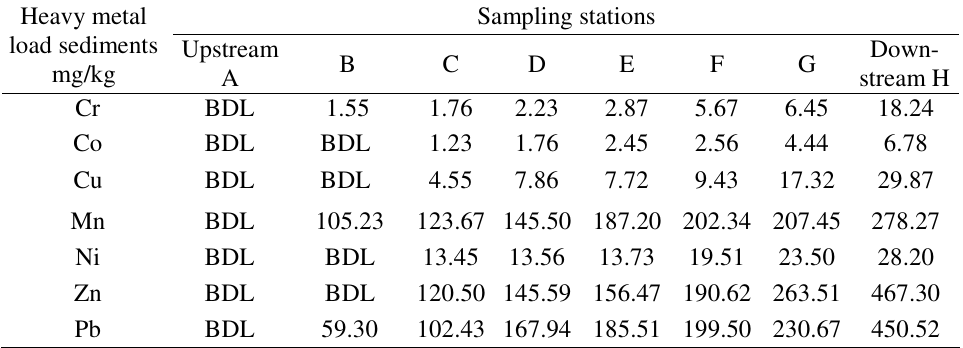
Table 6. Heavy metal in concentrations sediments (mg/kg) in various sampling stations.